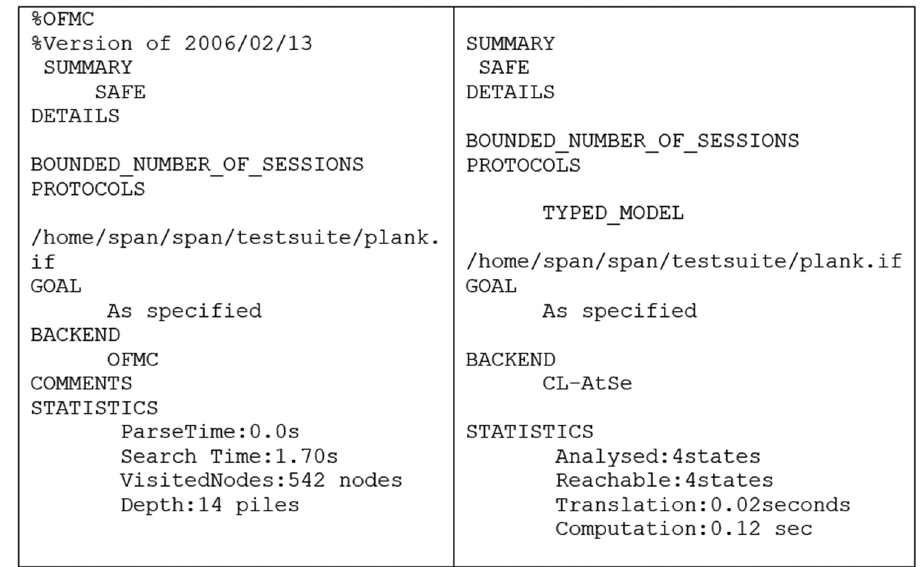
Figure 3: The illustration of design protocol tested by AVISPA tools.